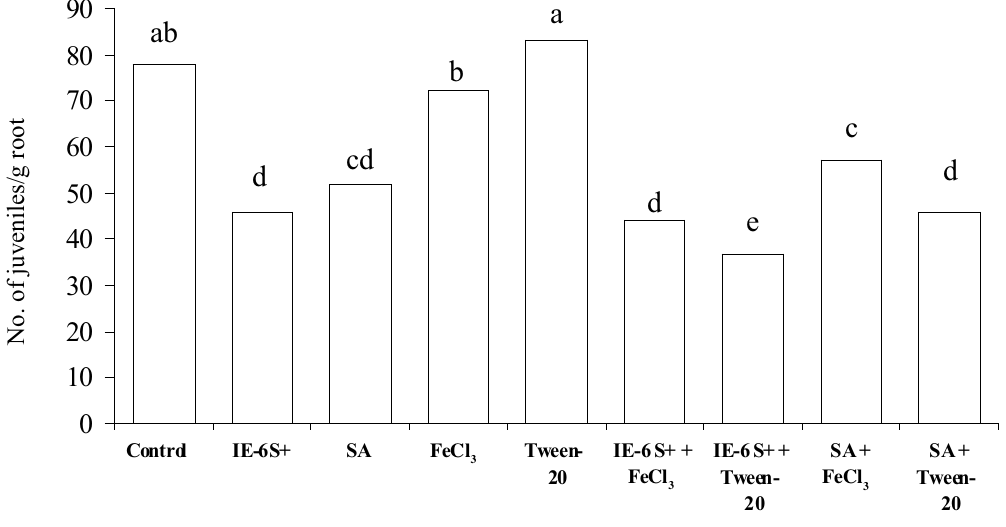
Fig. 1. The number of juveniles of Meloidogyne javanica that penetrated into the bacteria-free side of a split-root system. The other side was inoculated with either Pseudomonas aeruginosa (IE-6S + ); Salicylic acid (SA); Iron (FeCl Tween-20; IE-6S + + FeCl IE-6S + + Tween-20; SA + FeCl or SA + Tween-20. (Mean values with different letters are 3; 3 significantly different according to Duncan’s Multiple Range Test; P <0.05; n=10 obtained in two independent exper- iments each with 5